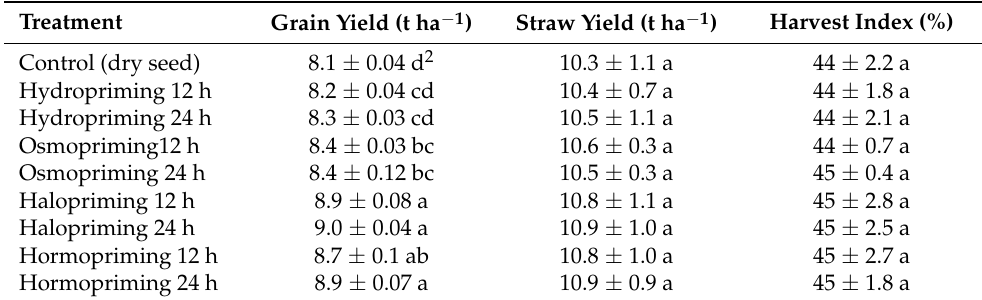
Table 12. Grain yield, straw yield and harvest index of DSR as affected by different seed priming in conventional DSR establishment method during 2018 at Ludhiana,